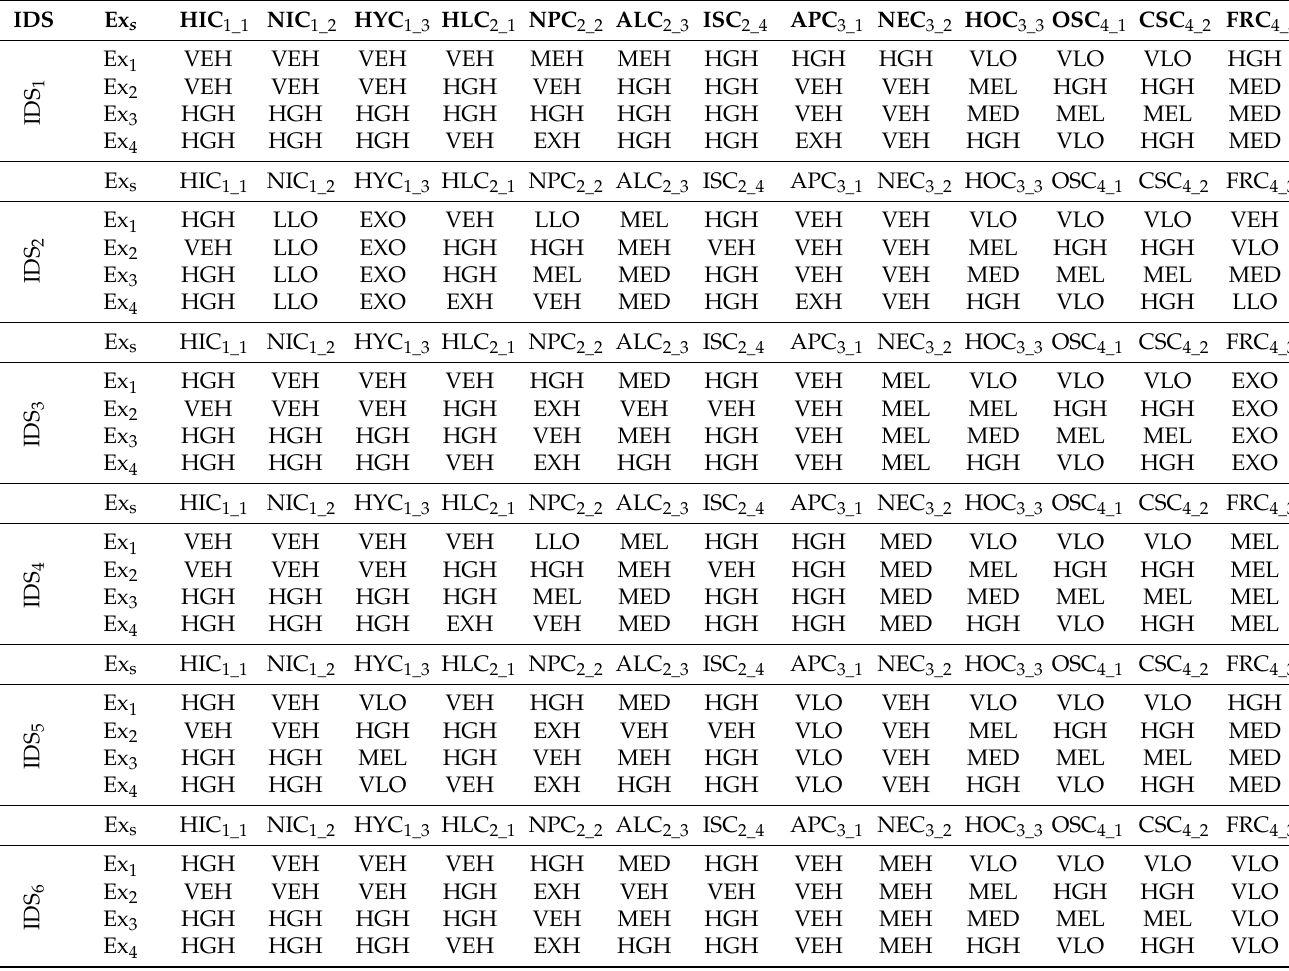
Table 11. Evaluations of the IDSs in terms of criteria.